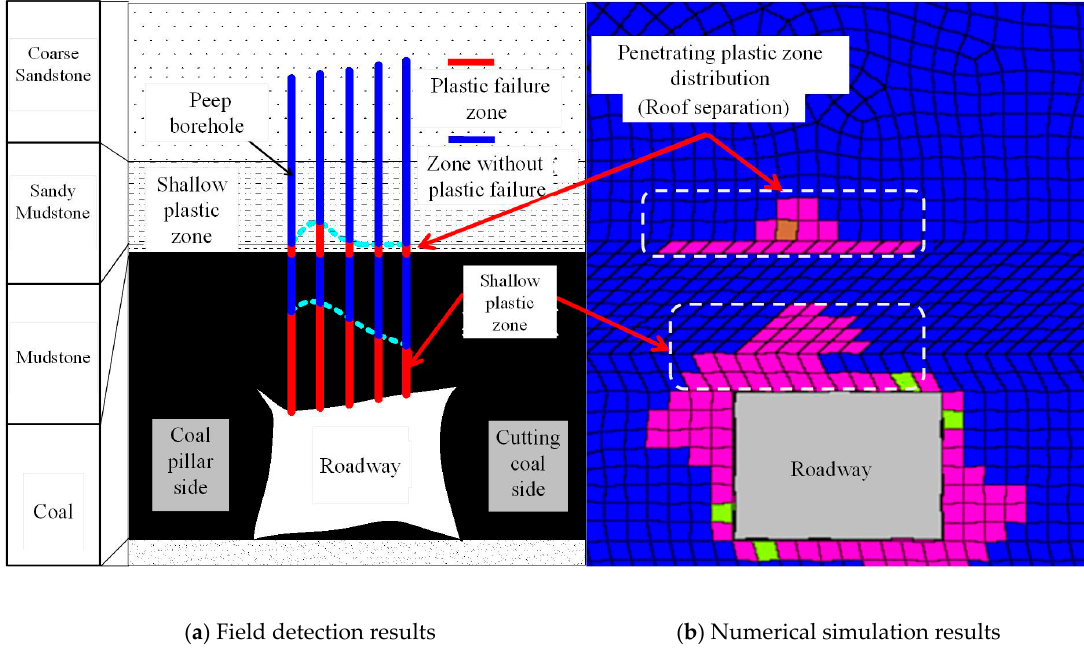
Figure 7. Comparison of numerical simulation and actual measurement results of plastic failure zone of roof after mining in the panel 81305 No. 2 return airway.